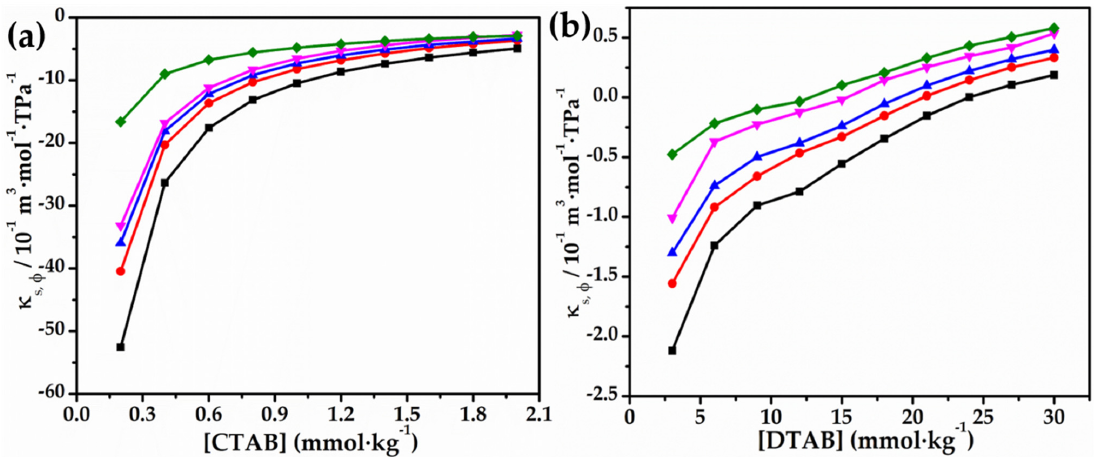
κ  Figure 4. Plots of φ Figure 2. Plots of s versus ( a ) [CTAB] and ( b ) [DTAB] in 0.010 mol∙kg –1 aqueous solution of , s versus ( a ) [CTAB] and ( b ) [DTAB] in 0.010 mol ∙ kg –1 aqueous solution of Figure 4. Plots of κ s , φ versus ( a ) [CTAB] and ( b ) [DTAB] in 0.010 mol · kg − 1 aqueous solution of glycyl glycyl dipeptide 293.15 K ( ■ ), 298.15 K (●), 303.15 K ( ▲ ), 308.15 K ( ▼ ) and 313.15 K ( ◆ ). dipetide293.15 K ( (cid:4) ), 298.15 K ( • ), 303.15 K ( (cid:78) ), 308.15 K ( (cid:72) ) and 313.15 K ( Table 3. Apparent molar volume,  V /10 −4 (m 3 ∙mol −1 ) values for CTAB and DTAB in pure water and 0.001, 0.005 and 0.010 mol∙kg −1 aqueous solution of glycyl dipeptide at different temperatures and pressure p = 100